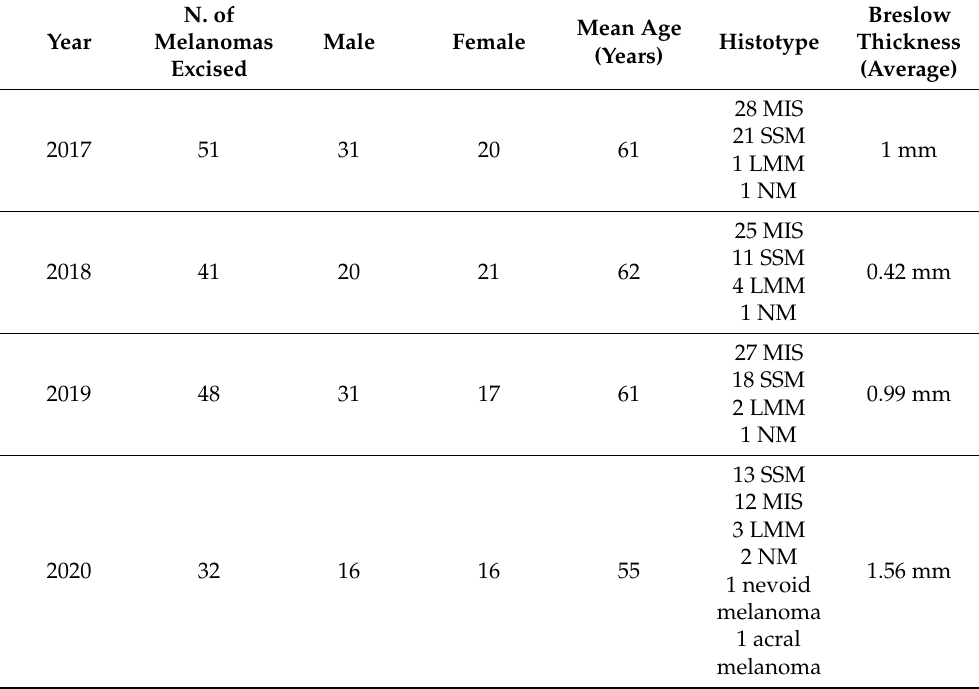
Table 1. Demographic and histological features of melanomas excised in the two-month period from May to June in 2017, 2018, 2019, and 2020. MIS: melanoma in situ; SSM: superficial spreading melanoma; LMM: lentigo maligna melanoma; NM: nodular